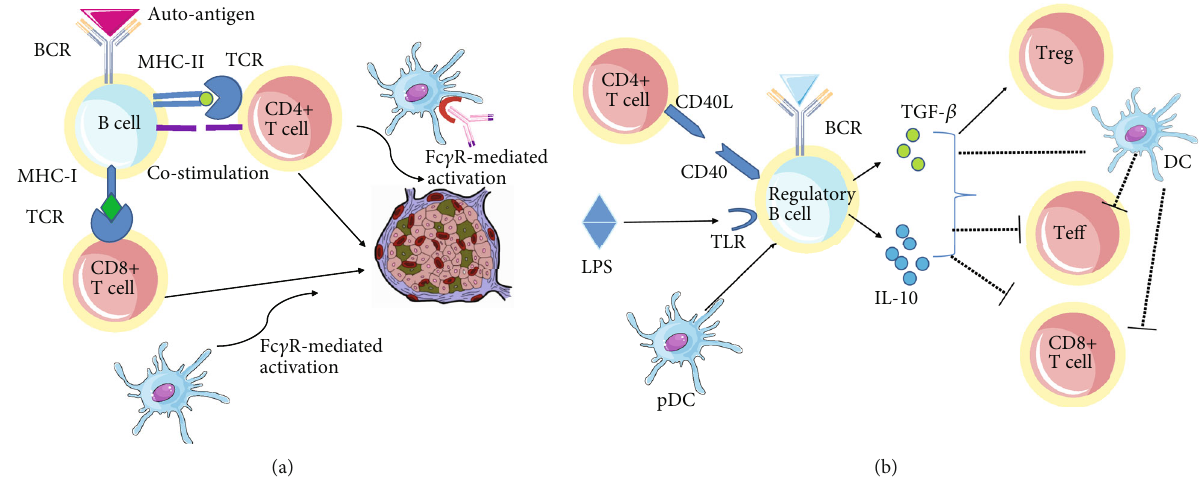
Figure 1: Mechanism of B cell involvement in self-reactive T cell-mediated β cell destruction. (a) The imbalance of pathogenic and regulatory B cells contributes to a loss of immune homeostasis. Autoreactive B cells may speci fi cally recognize autoantigen via unique BCR and present to autoreactive T cells through MHC-peptide-TCR, with increased expression of MHC classes I and II as well as elevated B7-1 and B7-2 levels. Autoantibodies produced by activated B cells enhance islet-reactive T cell activation through an Fc γ R-mediated manner. (b) Regulatory B cells can be induced by various stimuli including LPS, anti-IgM F(ab ′ ) antibody, CD40L, and plasmacytoid dendritic cells (pDC). By 2 contrast, the activated regulatory B cells produce IL-10, which suppresses the in fl ammatory potential of e ff ector T cells, alters the activity of antigen-presenting dendritic cells, and promotes regulatory T cell development and expansion. BCR: B cell receptor; LPS: lipopolysaccharide; MHC: major histocompatibility complex; TCR: T cell receptor; TLR: toll-like